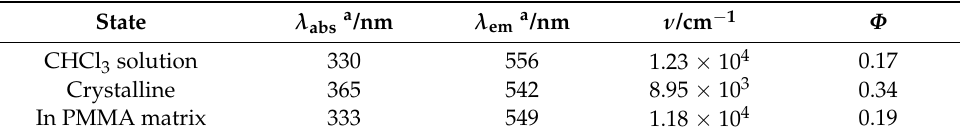
Figure 3. UV − vis absorption and emission spectra of 3TfAPI dissolved in CHCl 3 , in the crystalline state and dispersed in PMMA matrix with photographs of those under white light (UV off) and UV ( λ = 365 nm) irradiation (UV on). The photograph of 3TfAPI dissolved in CHCl 3 was taken at a concentration of 1.0 × 10 − 3 M. Table 1. Photoluminescence properties, absorption wavelengths ( λ abs ), emission wavelengths ( λ em ), Stokes shifts ( ν ), and quantum yields ( Φ ) of 3TfAPI dissolved in CHCl 3 , in the crystalline state and dispersed in PMMA